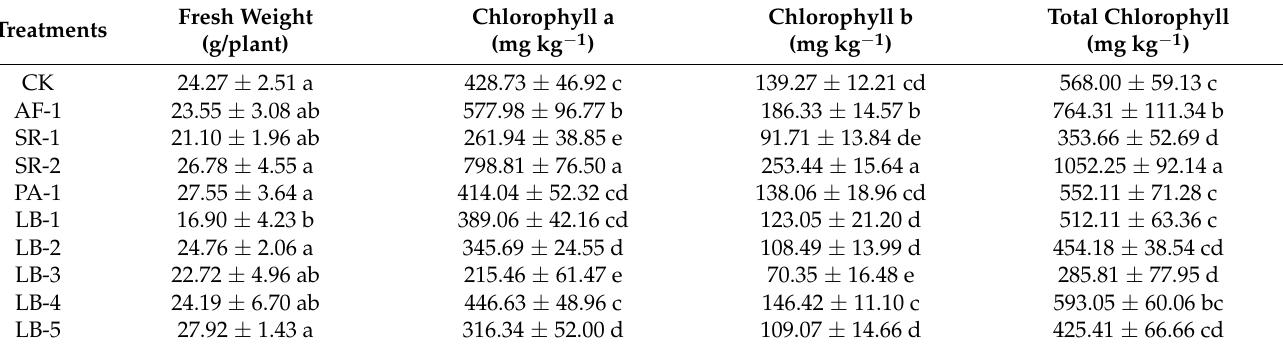
Table 3. The fresh weight, chlorophyll a, b and total chlorophyll content of lettuce as affected by different Cr-tolerant